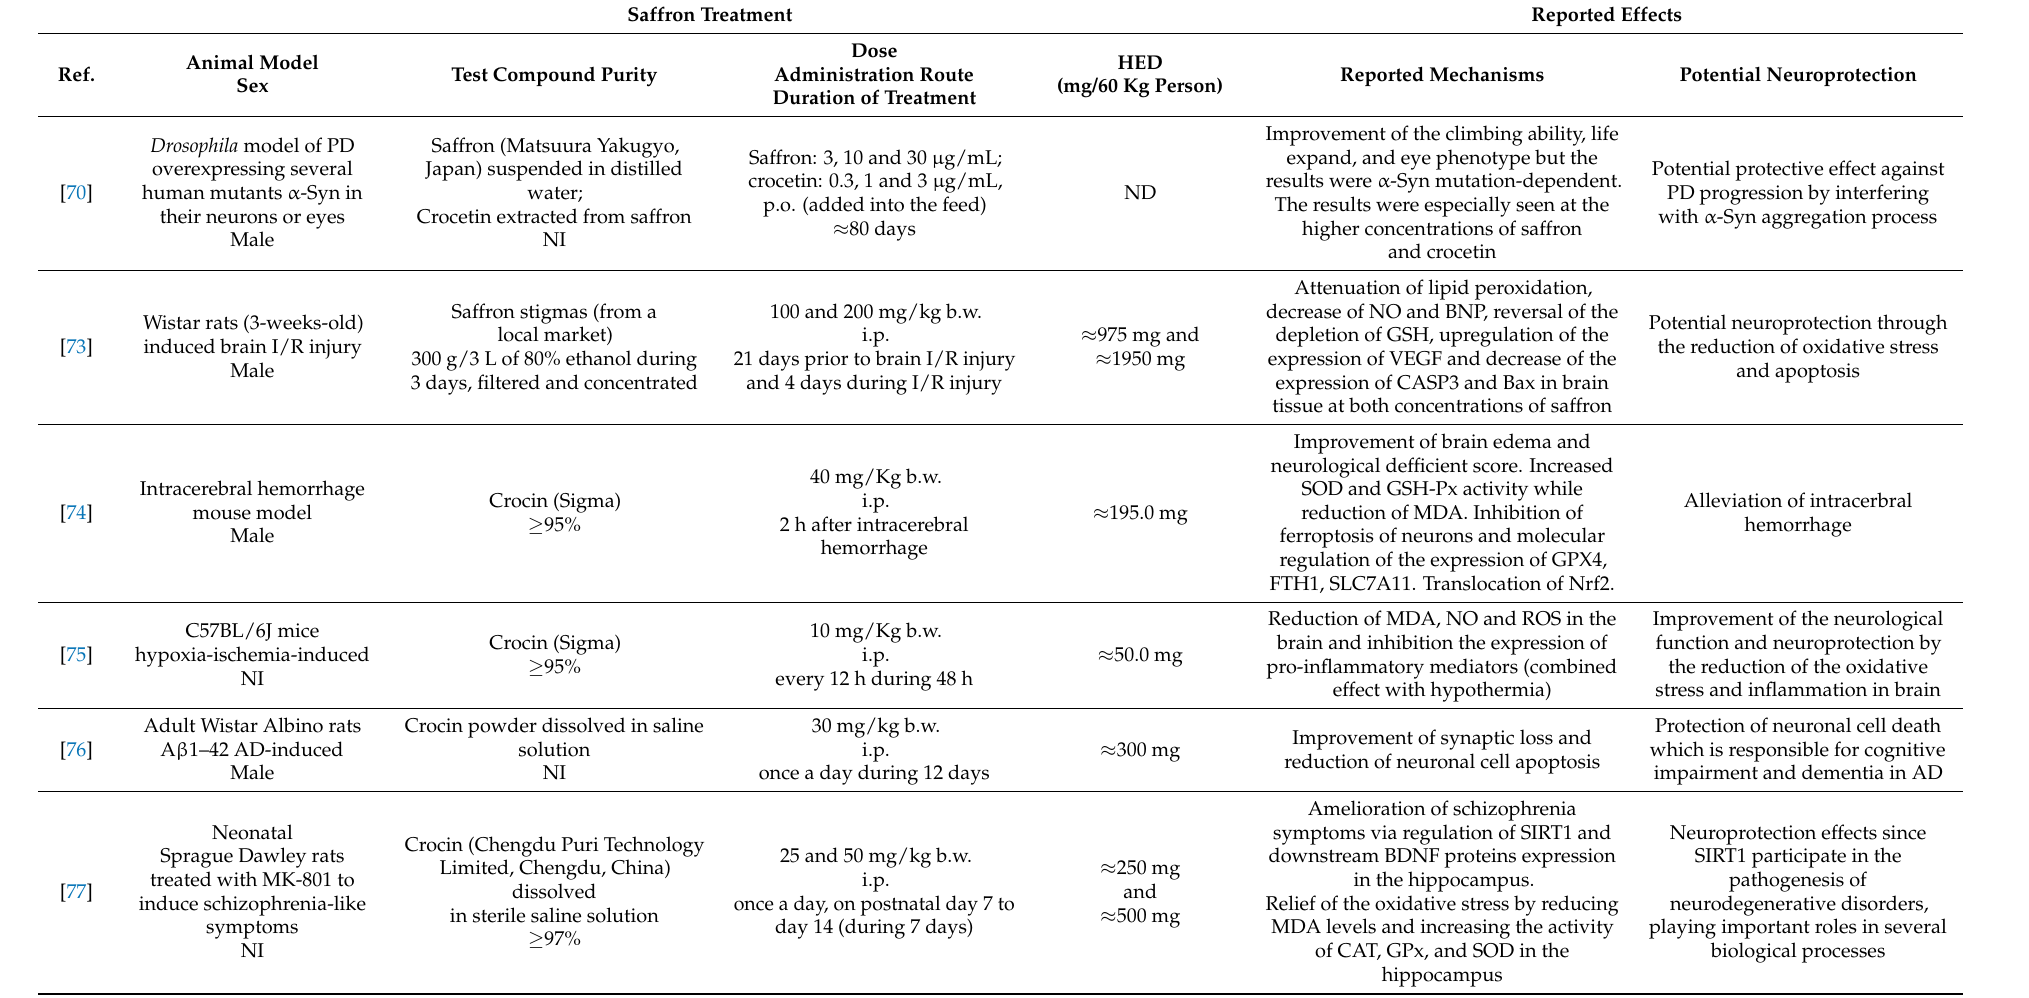
Table 5. Animal studies looking at the effects of saffron and its main bioactive constituents against neurological